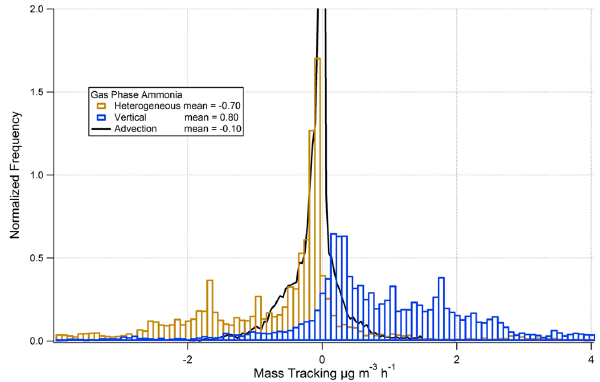
Fig. 6. Distribution 1 of important ammonia mass tracking opera- tors from the 2.5km AURAMS grid cell over Harrow shows het- erogeneous chemistry process to be a net sink of ammonia, while vertical exchange processes are a net